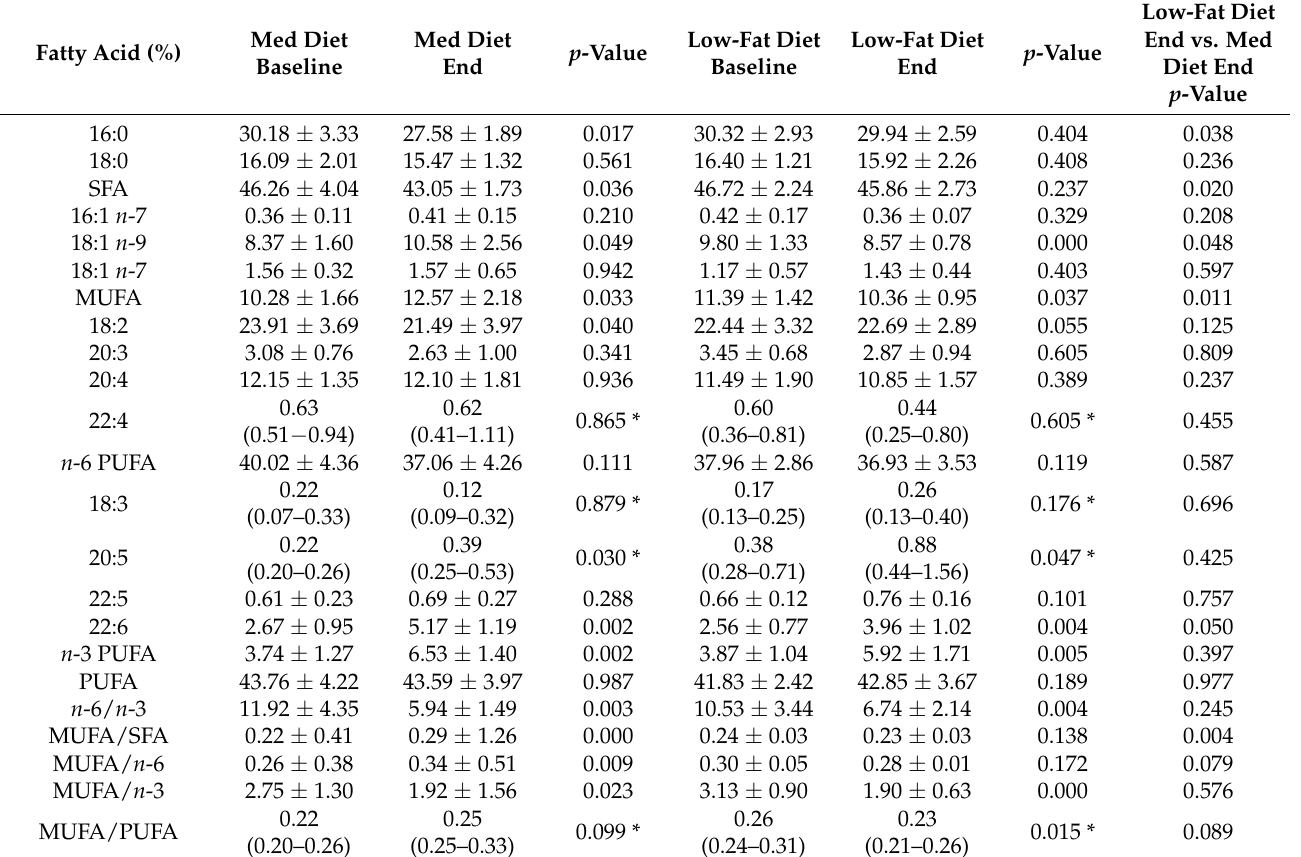
Table 3. Serum phospholipid fatty acid composition in NAFLD patients at baseline and after the dietary